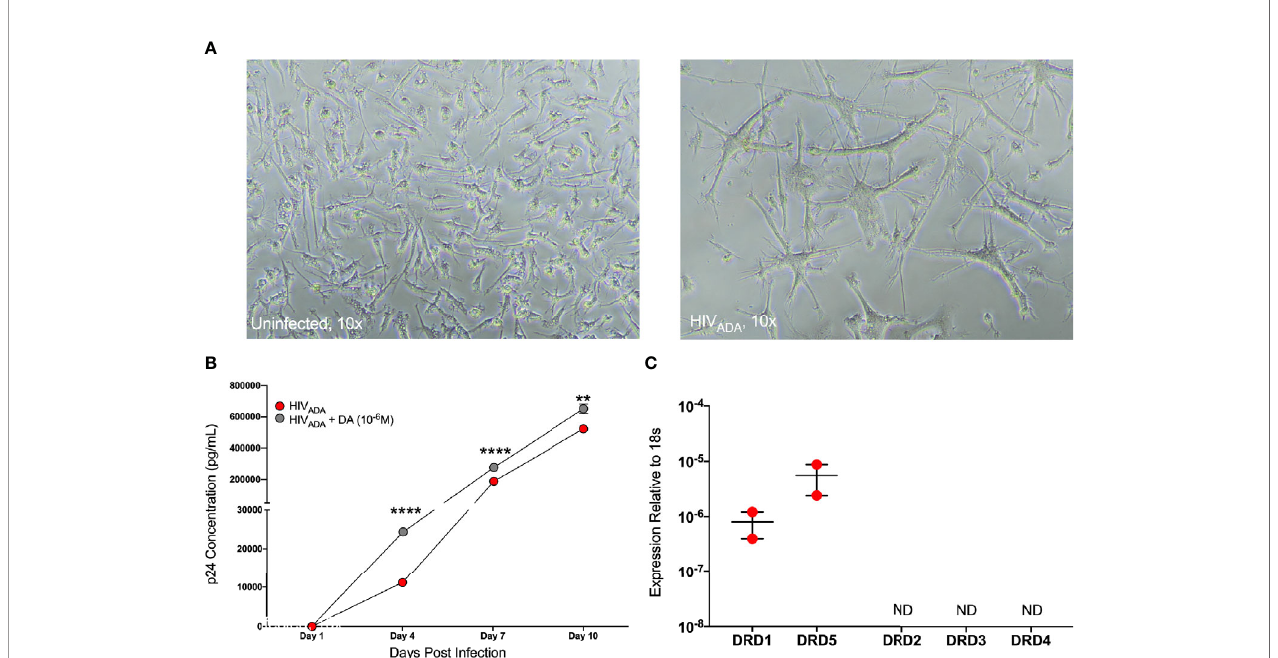
FIGURE 6 | iMicroglia are infectable with HIV and dopamine increases HIV replication. iMicroglia were inoculated with 1 ng/mL of HIV ADA or vehicle and concurrently treated with vehicle (diH 2 O) or dopamine (10 -6 M). (A) Representative bright fi eld images show uninfected or HIV-infected iMicroglia at 7 days post infection, showing high levels of cell fusion and giant cell formation in infected cultures relative to healthy rami fi ed microglia in mock-infected cultures. (B) Analysis of supernatant p24 levels over 10 days post-infection in one iMicroglia line (WT6) shows increasing viral replication over time. The p24 levels in dopamine-treated cultures were signi fi cantly higher than those in HIV-infected cultures treated with vehicle at every time point examined, indicating that dopamine does increase HIV infection in microglia (multiple t-tests corrected for multiple comparisons using the Holm-Sidak method, Day 4, ****p < 0.0001, t=53.35, df=4, HIV SEM=241.73, HIV+DA SEM=51.5; Day 7, ****p < 0.0001, t=27.52, df=4, HIV SEM=287.37, HIV+DA SEM=3189.41; Day 10, **p = 0.002, t=7.07, df=4, HIV SEM=2294.24, HIV+DA SEM=17989.88). (C) Quantitative RT-PCR analysis of dopamine receptor expression in this line of iMicroglia (WT6) showed that these cells express the D1-like dopamine receptors, DRD1 and DRD5, but not D2-like